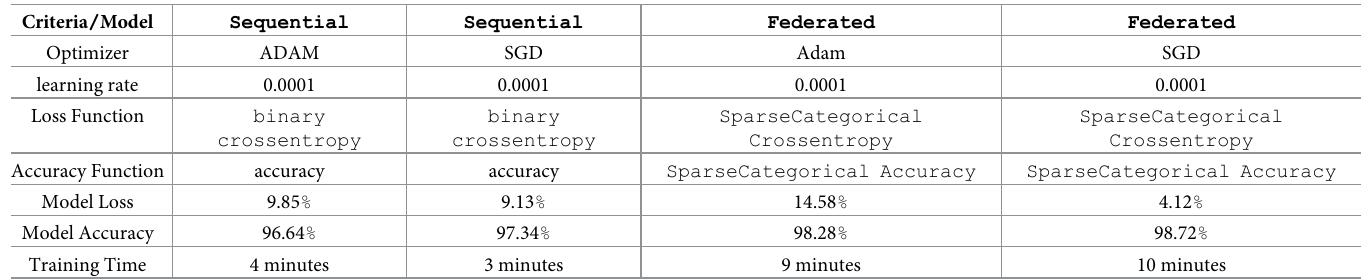
Table 2. Comparison between proposed models accuracy and loss on patient’s chest x-ray